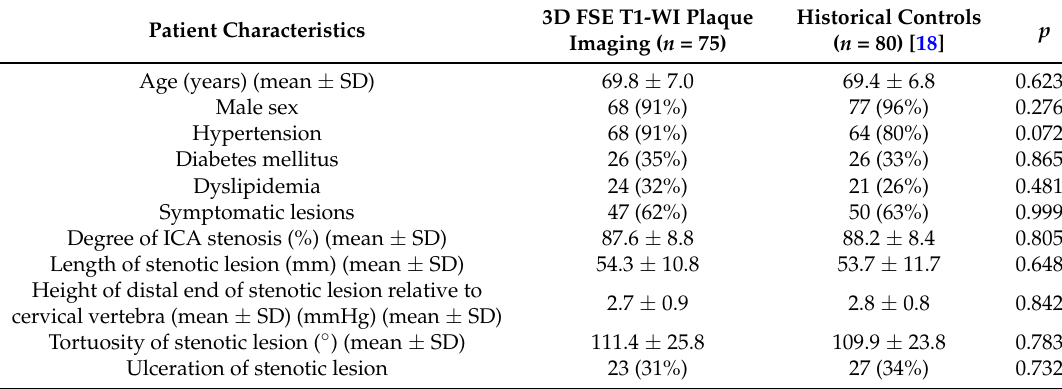
Table 1. Comparison of basic characteristics between patients undergoing 3D fast spin-echo (FSE) T1-weighted imaging (WI) plaque imaging and historical controls undergoing 2D T1-WI SE plaque imaging. ICA, internal carotid artery; SD, standard deviation.